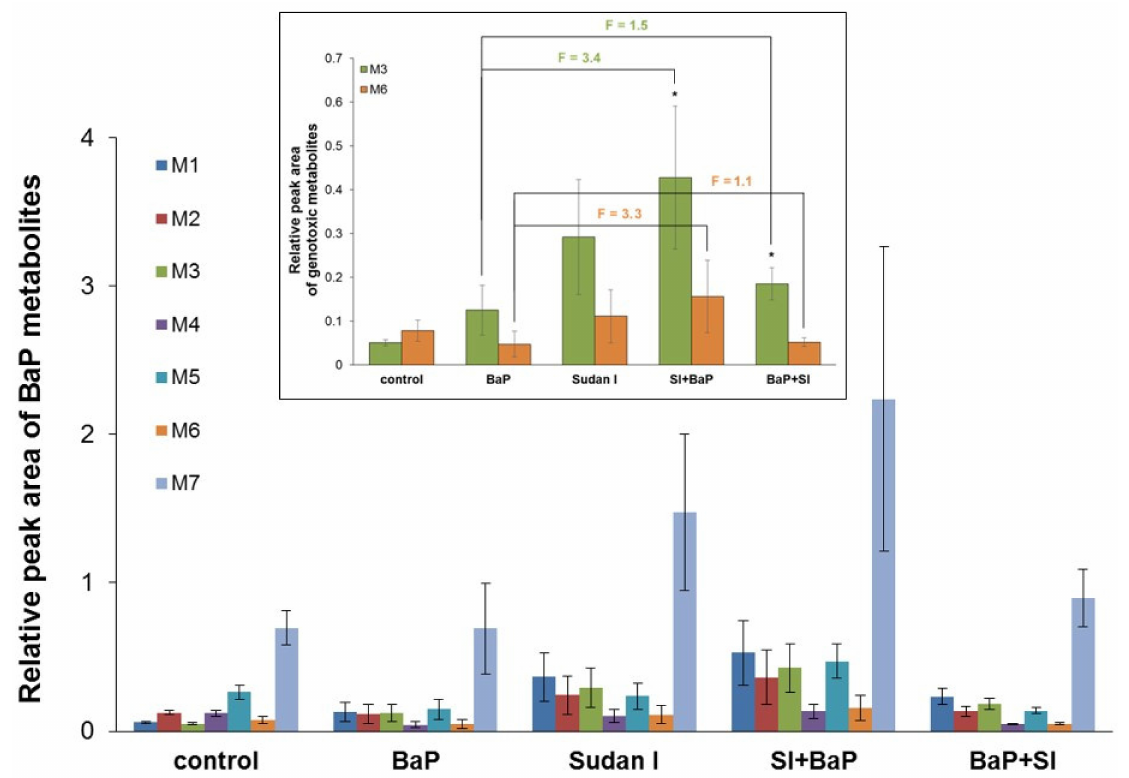
Figure 8. HPLC detection of BaP metabolites from in vitro incubations of BaP, NADPH and hepatic microsomal fractions from control (untreated) rats and rats exposed to BaP alone, Sudan I alone, Sudan I before BaP treatment (SI + BaP) or Sudan I after BaP treatment (BaP + SI). Peak areas of BaP metabolites were related to 1 nmol of total microsomal CYP. Values are given as mean ± S.D. from three parallel experiments. M1—BaP-9,10-dihydrodiol, M2—BaP-4,5-dihydrodiol, M3—BaP-7,8-dihydrodiol, M4—BaP-1,6-dione, M5—BaP-3,6-dione, M6—BaP-9-ol, M7—BaP-3-ol. Insert : Detailed excerpt from the graph showing results of HPLC detection of genotoxic BaP metabolites M3 (BaP-7,8-dihydrodiol) and M6 (BaP-9-ol). Numbers above columns (“F”) indicate fold changes in relative peak areas in comparison to animals treated with BaP alone. Statistical comparison was performed by t -test analysis: no statistically significant difference between rats exposed to BaP alone and BaP in combination with Sudan I; * p < 0.05—significantly different from control (untreated)